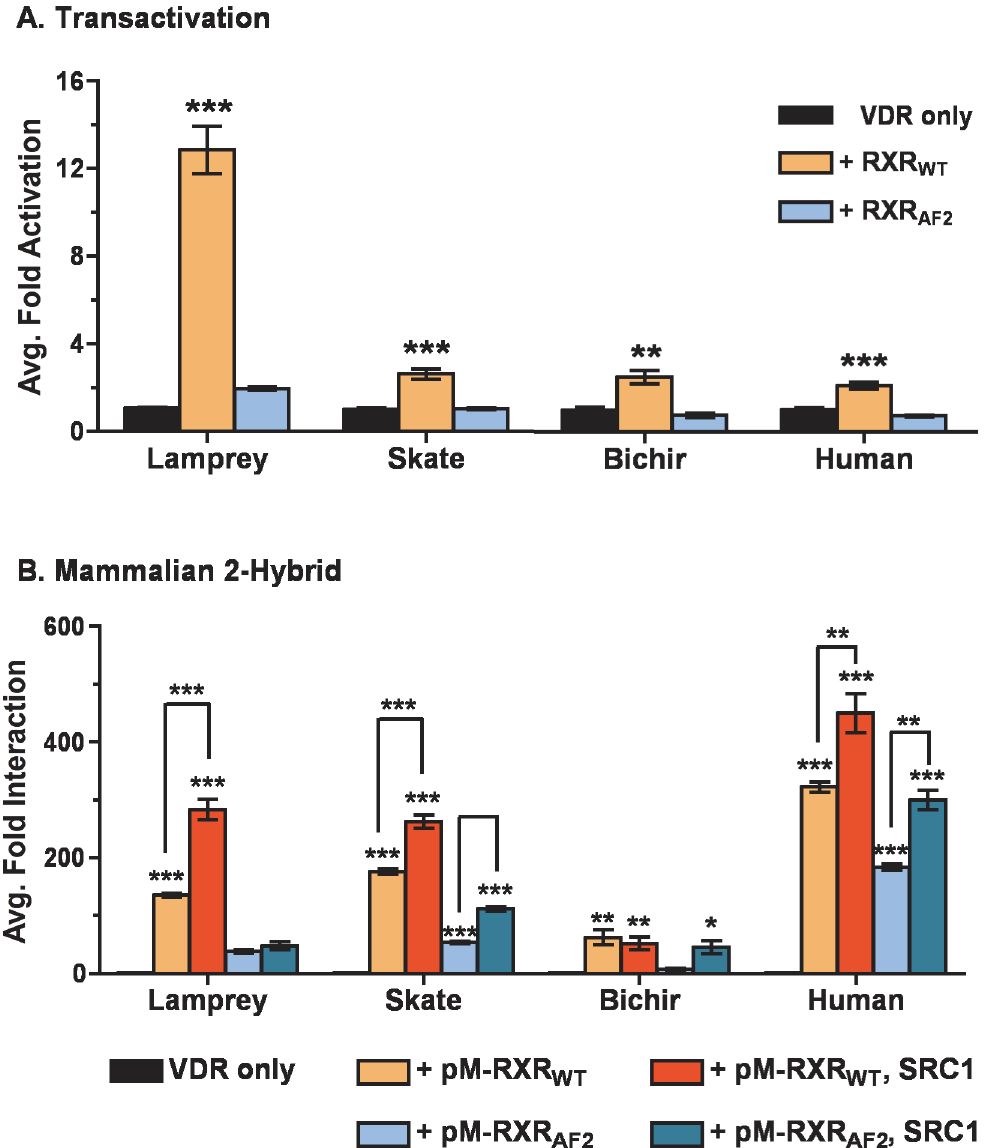
Fig 6. Assessment of VDR-RXR interactions. (A) Analysis of overexpressed RXR on VDR transactivation and (B) VDR-RXR heterodimerization in response to 1, 25D 3 . (A) HepG2 cells were transiently transfected with pSG5-VDR, the XREM-Luc reporter, and the pRL-CMV internal luciferase control as described previously in Materials and Methods. Select assays were cotransfected with pCDNA-RXR WT (orange bars) or pCDNA-RXR AF2 mutant (blue bars). Cells were treated with 120 nM 1, 25D 3 for 24 hours. VDR response was measured via dual-luciferase assays. Data are represented as the average fold activation normalized to VDR alone (no RXR) ± SEM (n = 4). Asterisks represent a significant increase in transactivation compared to the VDR control: *** = p < 0.001, ** = p < 0.01, * = p < 0.05. (B) Mammalian two-hybrid assays were conducted to study VDR-RXR heterodimerization in response to 1, 25D 3 . HepG2 cells were transiently transfected with pVP16-VDR as prey and pM-RXR WT (light orange bars) or pM-RXR AF2 (light blue bars) as bait, along with the Gal4 luciferase reporter 5XGal4-TATA-Luc and the pRL-CMV internal luciferase control. Select experiments were also cotransfected with pSG5-SRC1 where indicated. Cells were exposed to 120 nM 1, 25D 3 in media for 24 hours. Protein-protein interaction was measured via dual-luciferase assays as described in the Materials and Methods. Data are represented as the mean fold interaction ± SEM (n = 4). Data are normalized to VDR + empty pM vector (no RXR). Asterisks indicate significance: *** = p < 0.001, ** = p < 0.01, * = p < 0.05. Asterisks above brackets indicate the addition of pSG5-SRC1 significantly enhanced VDR-RXR